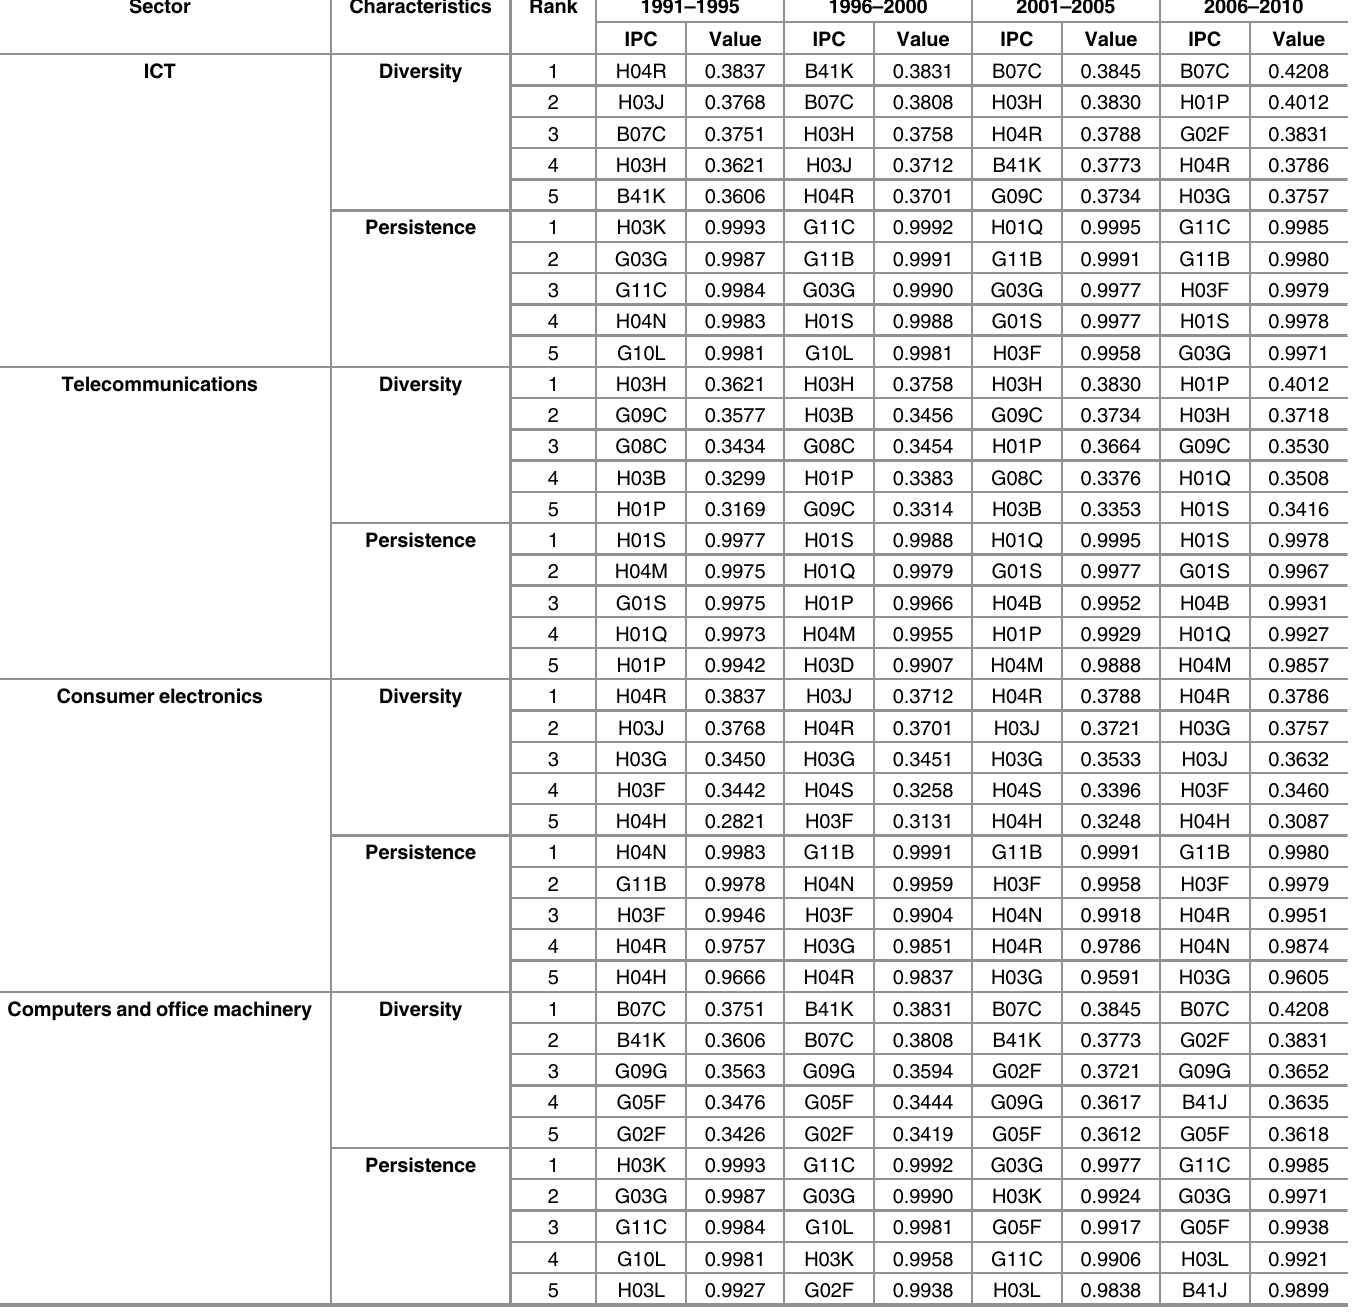
Table 9. Diversity and Persistence Values of IPCs in ICT, BT, and NT Sectors in the US.